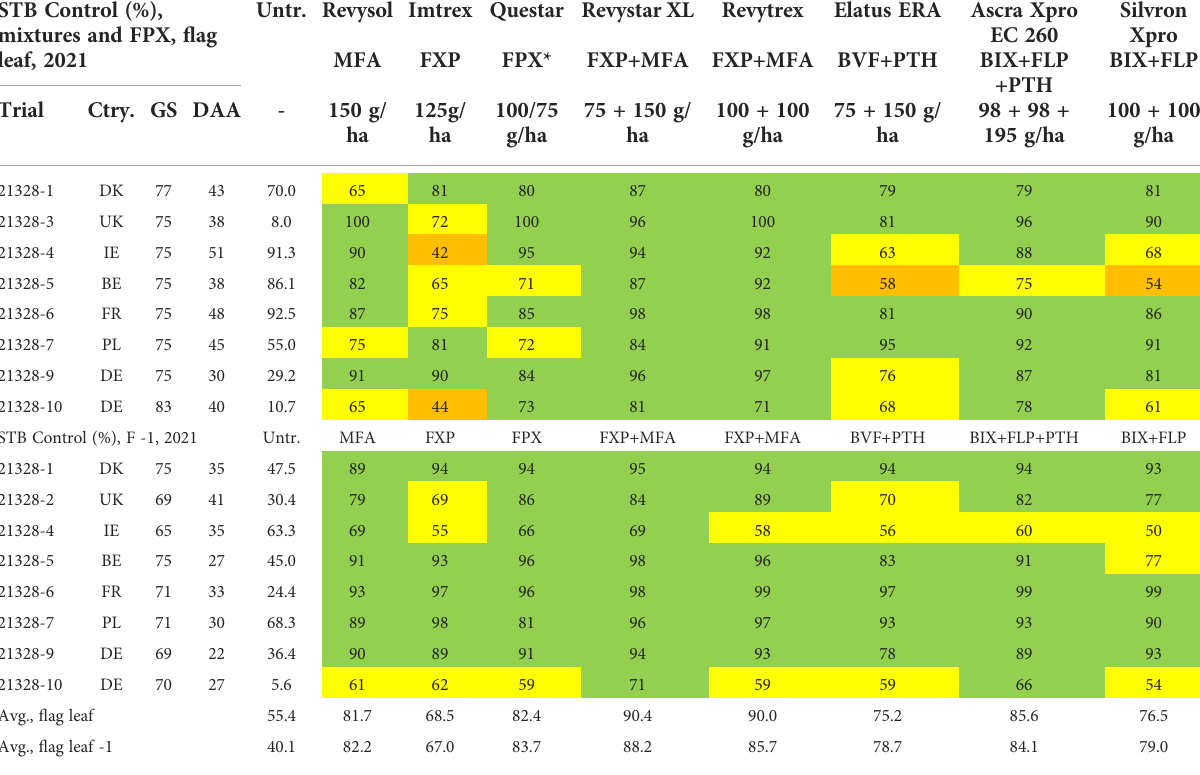
TABLE 5 Overview STB control from mixtures and FPX and disease severity (%) in untreated (untr.) plots. STB Control (%), mixtures and FPX, fl